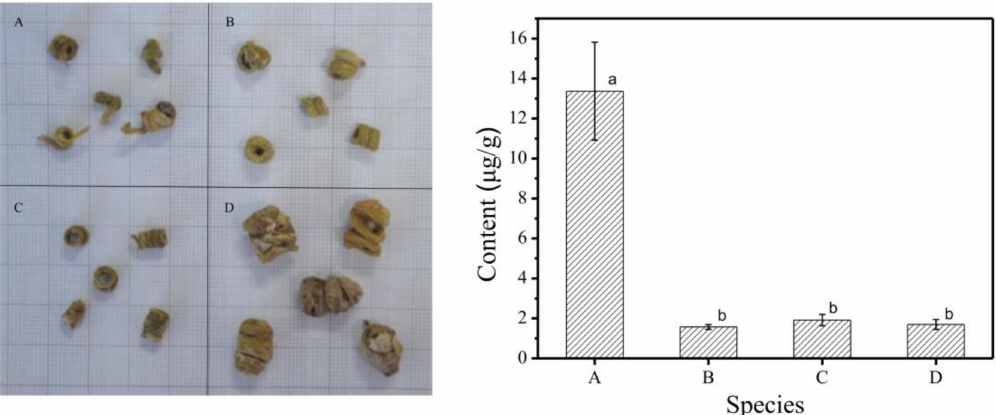
Figure 4. The content of gigantol in different species of Fengdou. Note: a and b are multiple comparison letter markings; the same letter indicates that the difference is not significant; the level of p < 0.01 indicates extremely significant; ( A ): Dendrobium huoshanense Fengdou, ( B ): Dendrobium officinale Fengdou, ( C ): Dendrobium moniliforme Fengdou, ( D ): Dendrobium devoninum Paxt Fengdou; the left figure is different species of Dendrobium Fengdou and the right figure is content of gigantol in different species of Dendrobium